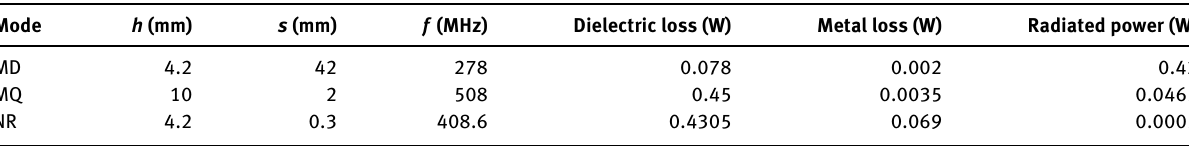
Table 1: Geometrical parameters, resonant frequencies, losses and radiated power of the dielectric disk resonator excited with metal loop operating on MD, MQ and NR